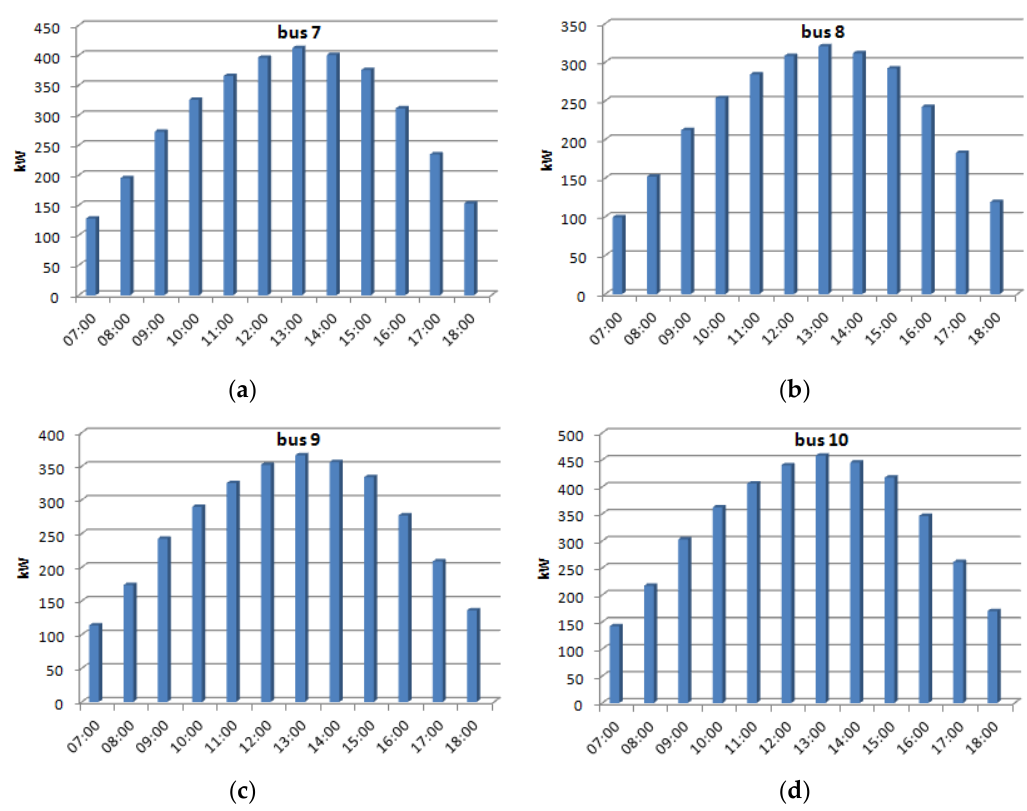
Figure 11. Mean values and standard deviations of PV power at different buses: ( a ) bus 7; ( b ) bus 8; ( c ) bus 9; and ( d ) bus 10. Table 3. Time-of-use pricing.